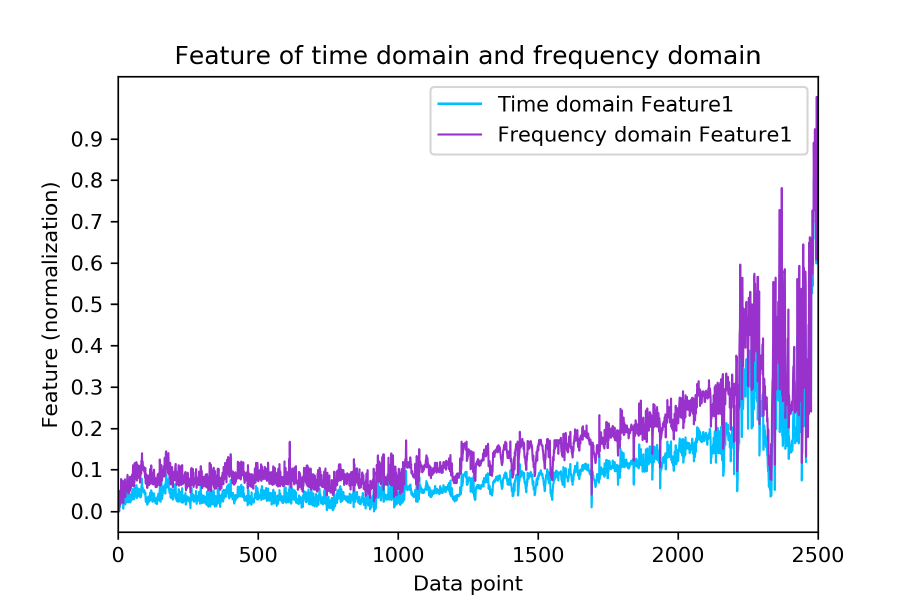
Figure 6. The change trend of time domain and frequency domain features with monitoring